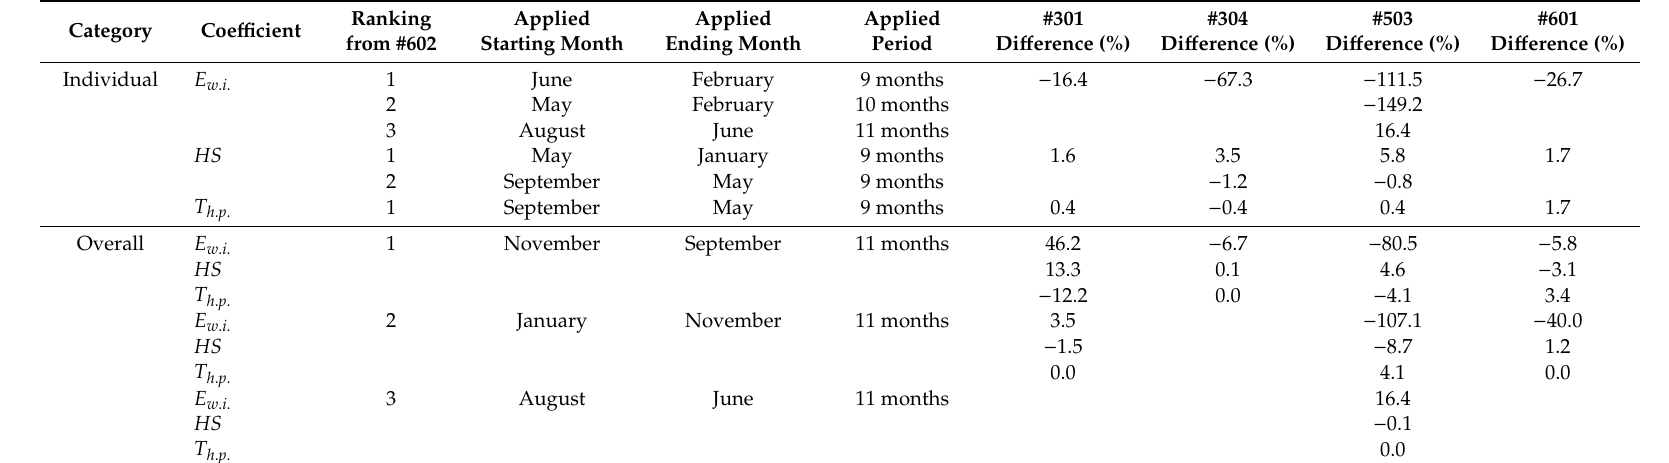
Table 8. Results from the verification process.